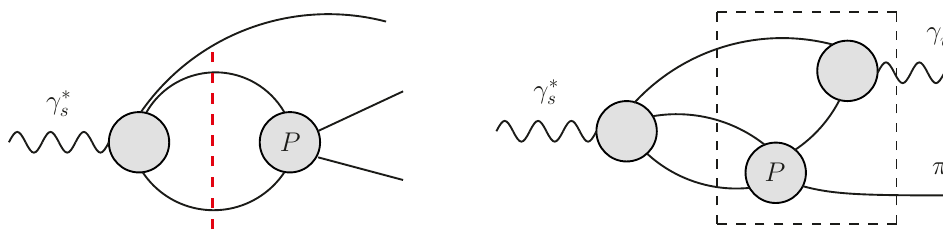
3 (cid:25) amplitude (left) and the approximation s ! (cid:13) (cid:3) (cid:25) 0 that follows from the two-body rescattering (right). The s ! v